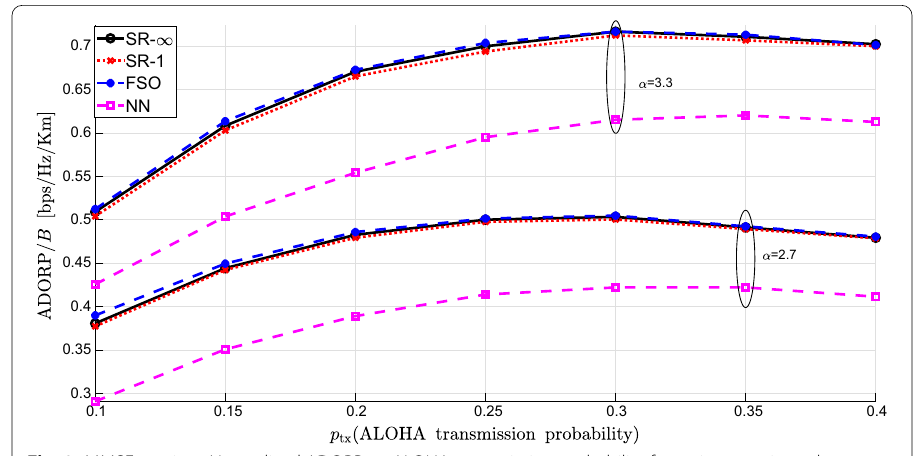
Fig. 3 MMSE receiver: Normalized ADORP vs. ALOHA transmission probability for various routing schemes, where N = 2, π r 2 RZ = 10 and α = { 2.7,3.3 }